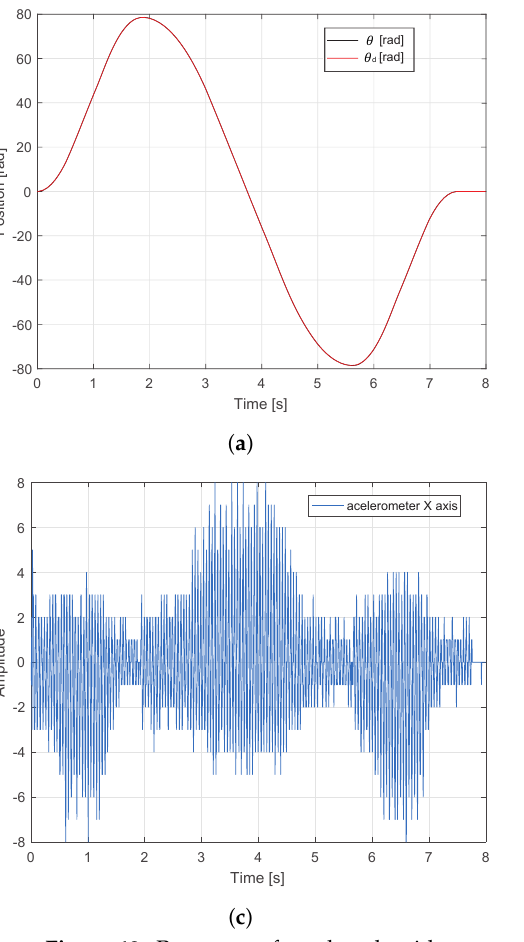
Figure 12. Response of test bench with a trapezoidal velocity profile and GA applied. ( a ) Angular position and reference. ( b ) Angular and desired velocity. ( c ) Accelerometer X axis. ( d ) Error and control signal.